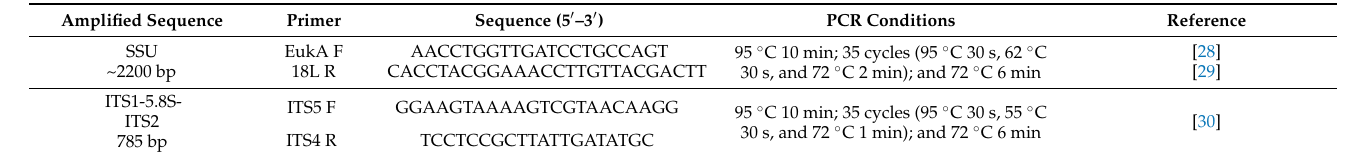
Table 2. Primers and PCR conditions for the SSU and ITS1-5.8S-ITS2